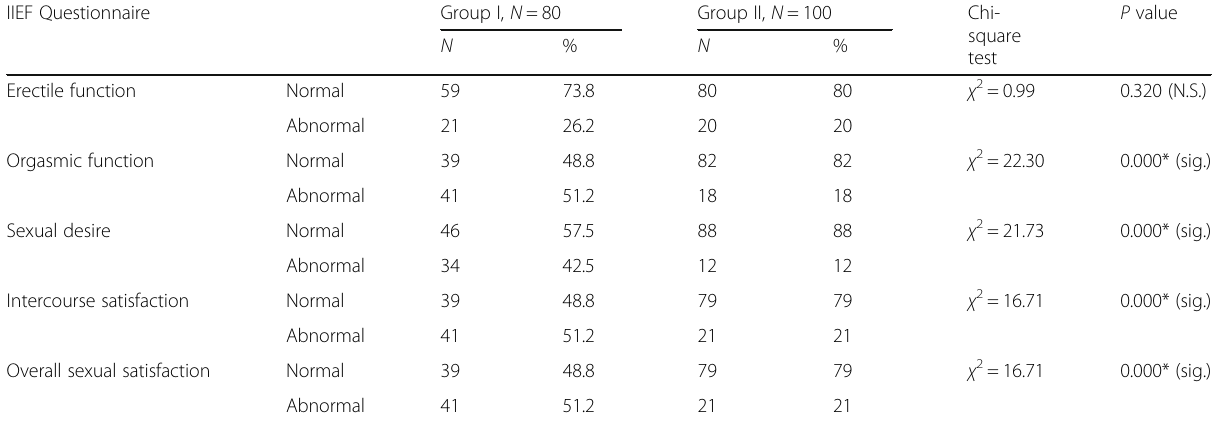
Table 5 Patterns of sexual functions among patients of group I and group II